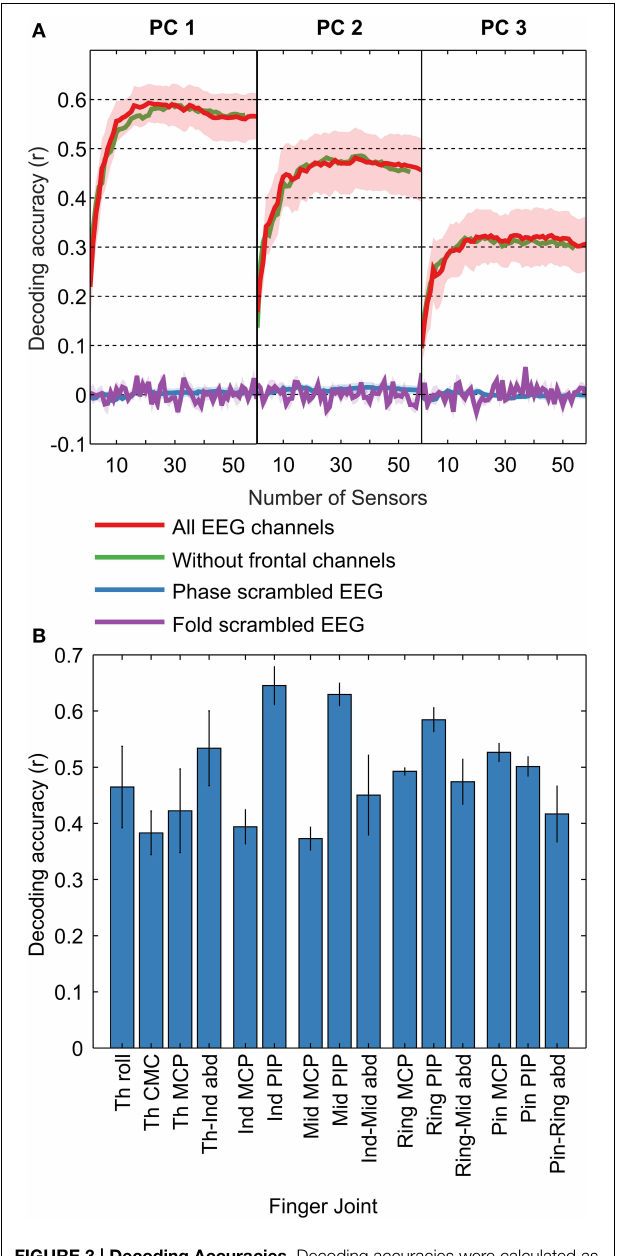
FIGURE 3 | Decoding Accuracies. Decoding accuracies were calculated as the median across 8-folds for each of the 58 EEG sensor (channel) sets, for all subjects, for the first three PCs and the 15 joint angles. (A) Mean decoding accuracies across subjects are shown in red ( ± s.e.m; shaded regions) for PC1, PC2, and PC3. As the number of channels used in the decoding increases from 1 to 58, the curves shows a rapid increase followed by a slow decrease. To assess the validity of our results, we also calculated chance levels using two methods: (1) by scrambling the phase of the EEG and (2) by scrambling the EEG trial indices. The mean decoding accuracy ( ± s.e.m; shaded regions) for the “phase scrambled” and “fold scrambled” is shown in blue and purple traces, respectively. Decoding accuracies are seen to be far above chance levels, indicating the validity of our method. To assess the impact of ocular artifact on the decoding accuracy, we omitted 4 frontal EEG channels most affected by such artifacts and recalculated the decoding